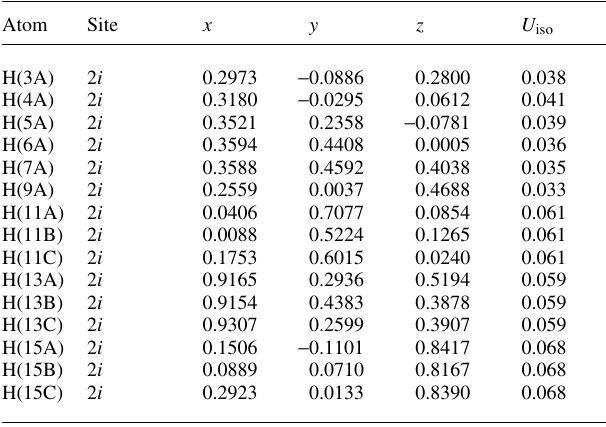
Table 2. Atomic coordinates and displacement parameters (in Å 2 )